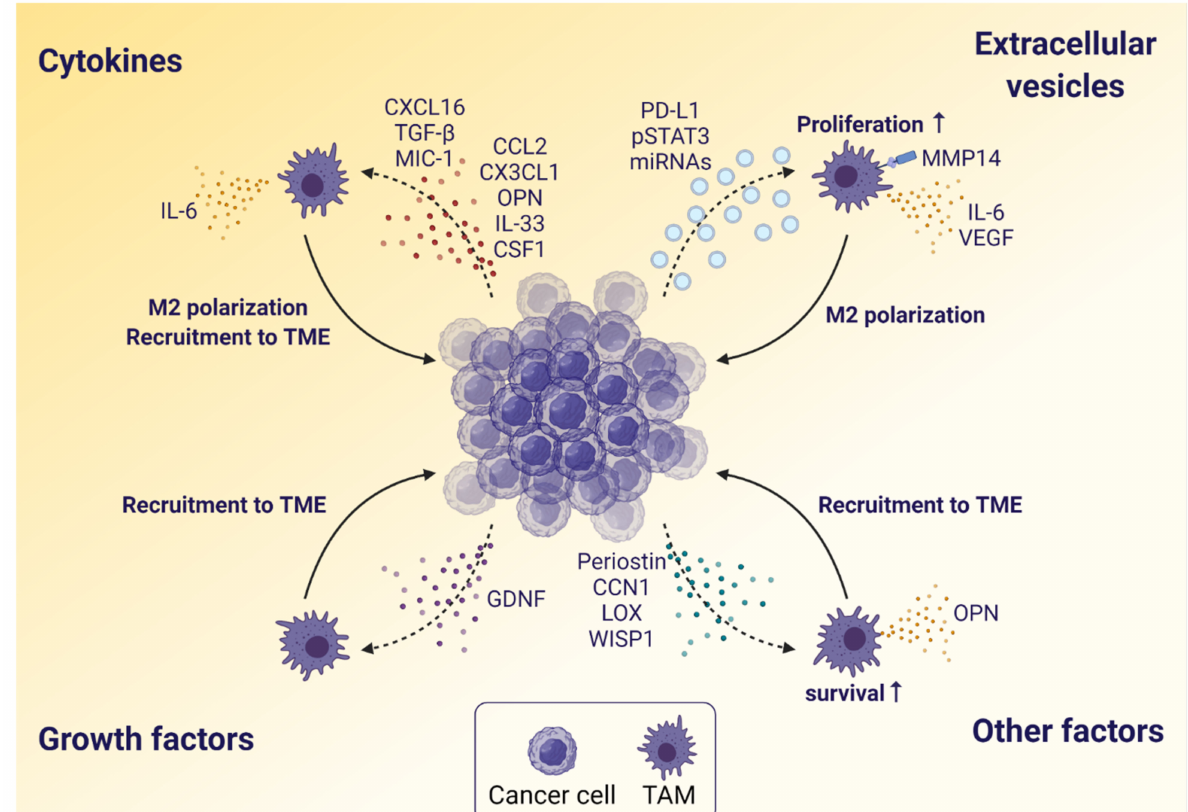
Figure 2. The influence of glioblastoma cells on TAMs. Glioblastoma cells secrete various factors that affect TAMs in different ways. Secreted cytokines lead to recruitment of TAMs to the TME, and to polarization of TAMs towards the pro-tumorigenic M2-like phenotype. In addition, TAMs are stimulated to secrete cytokines that further enhance recruitment and tumor invasion. Secreted growth factors also lead to recruitment of TAMs. Glioblastoma cells can also release extracellular vesicles, which are taken up by TAMs and affect their phenotype by induction of M2-like polarization and expression of matrix metalloproteinase 14 (MMP14), IL-6 and vascular endothelial growth factor (VEGF), contributing to a more progressive tumor. In addition, TAM proliferation may be increased. Other factors are secreted as well, leading to recruitment of TAMs to the TME as well as to stimulation of TAM survival and cytokine secretion. Abbreviations: C-X-C motif chemokine ligand (CXCL) 16 (CXCL16), macrophage inhibitory cytokine-1 (MIC-1), C-C motif chemokine ligand (CCL), C-X3-C